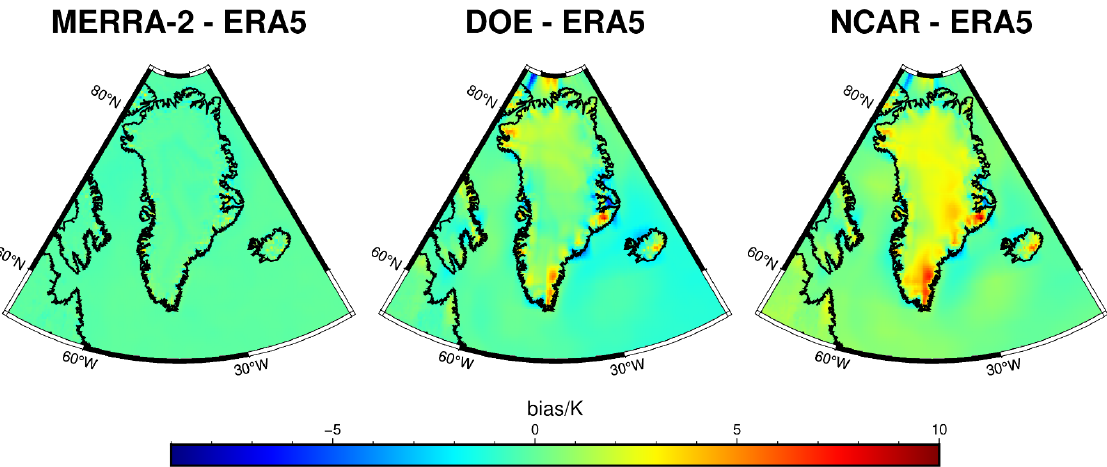
Figure 8. Regional T (cid:2923) differences between MERRA-2, NCEP/DOE, NCEP/NCAR, and ERA5 in Greenland.